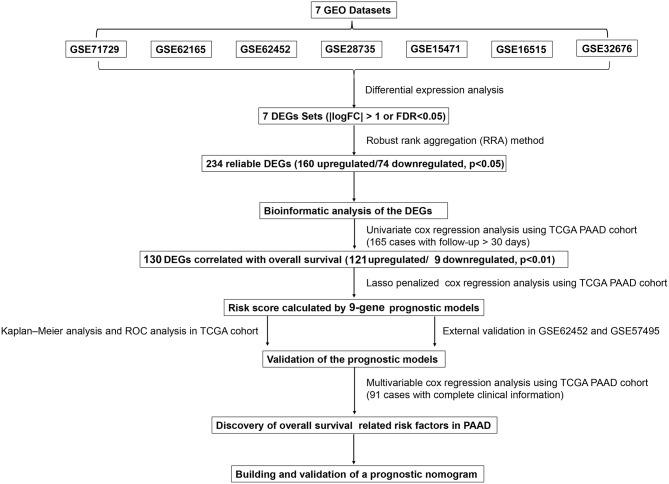
Flowchart presenting the process of establishing the gene signature and prognostic nomogram of pancreatic cancer in this study.